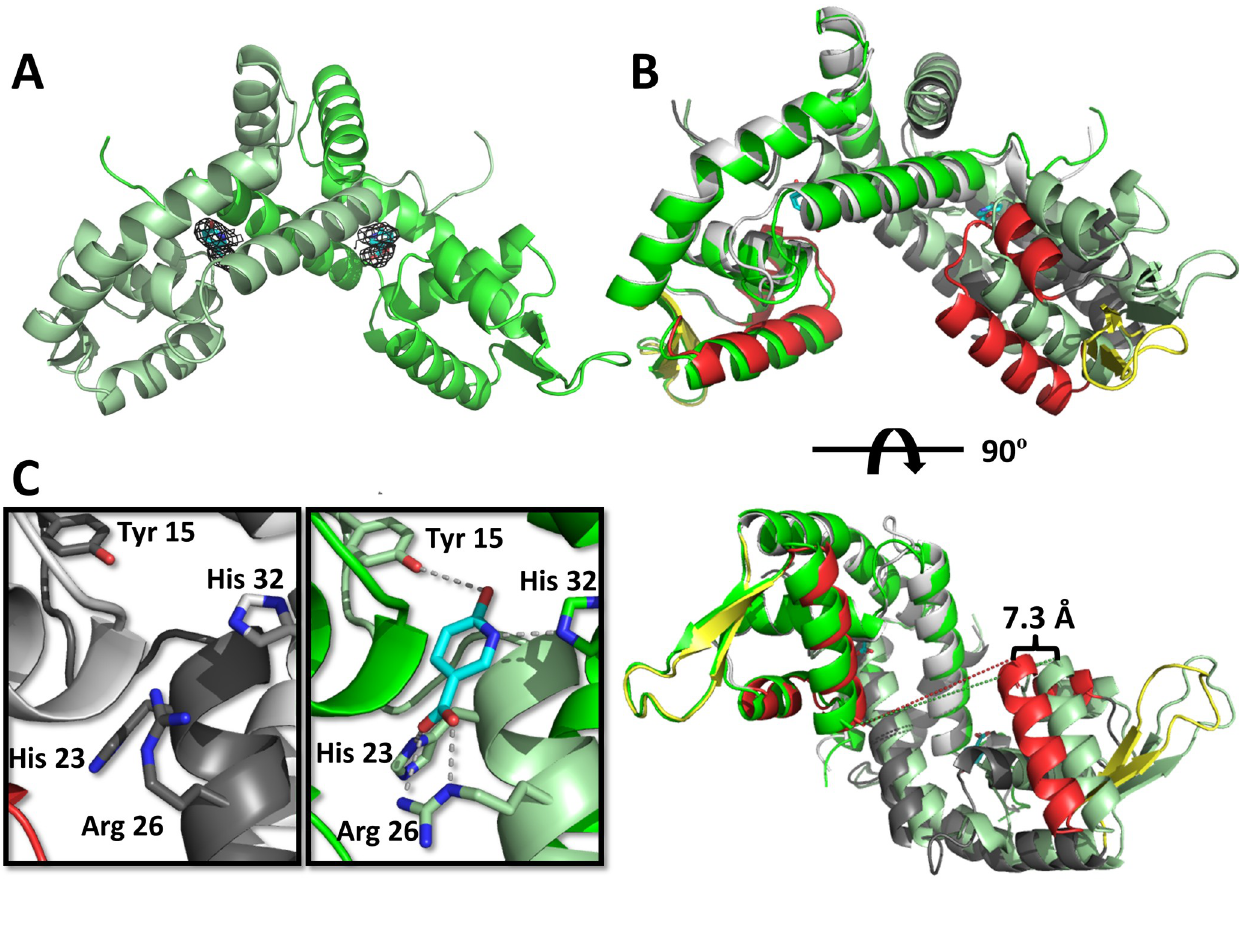
Fig 3. Structure of BpsR bound to 6-HNA (6HNA-BpsR). (A) 6HNA-BpsR structure showing the location of the binding pockets within the dimer. The 6HNA 2F o -F c map is contoured to 2.0 σ . (B) The superimposed BpsR (light and dark gray) and 6HNA-BpsR (green) structures reveal a 7.3 Å shift in the location of the recognition helix indicating that the shift prevents DNA binding (C) A magnification of the binding pocket of the BpsR (left) and 6HNA-BpsR (right) structures to show the changes that occur with the residues participating in binding of 6HNA. There is a 5 Å rotational shift of Arg26 in order to accommodate 6HNA.